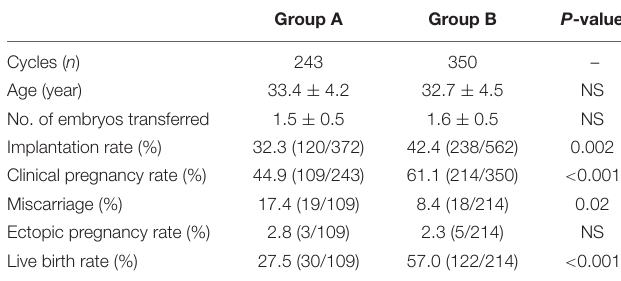
TABLE 5 | Comparison of blastocyst transferred cycles resulting in clinical outcomes according to whether they are originating from discarded or normal